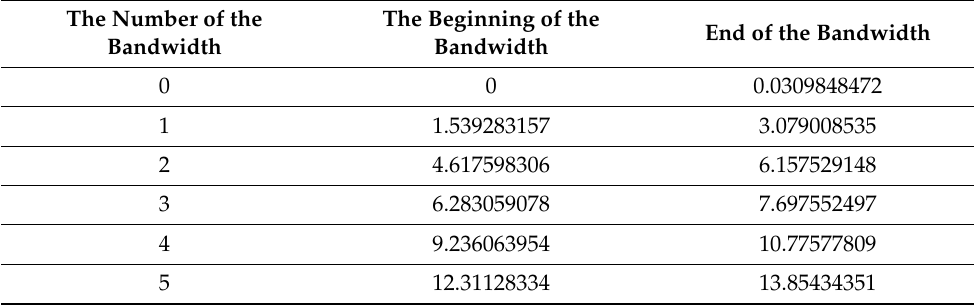
Table 2. The transmission frequency bands for the linear concentration of water in air.